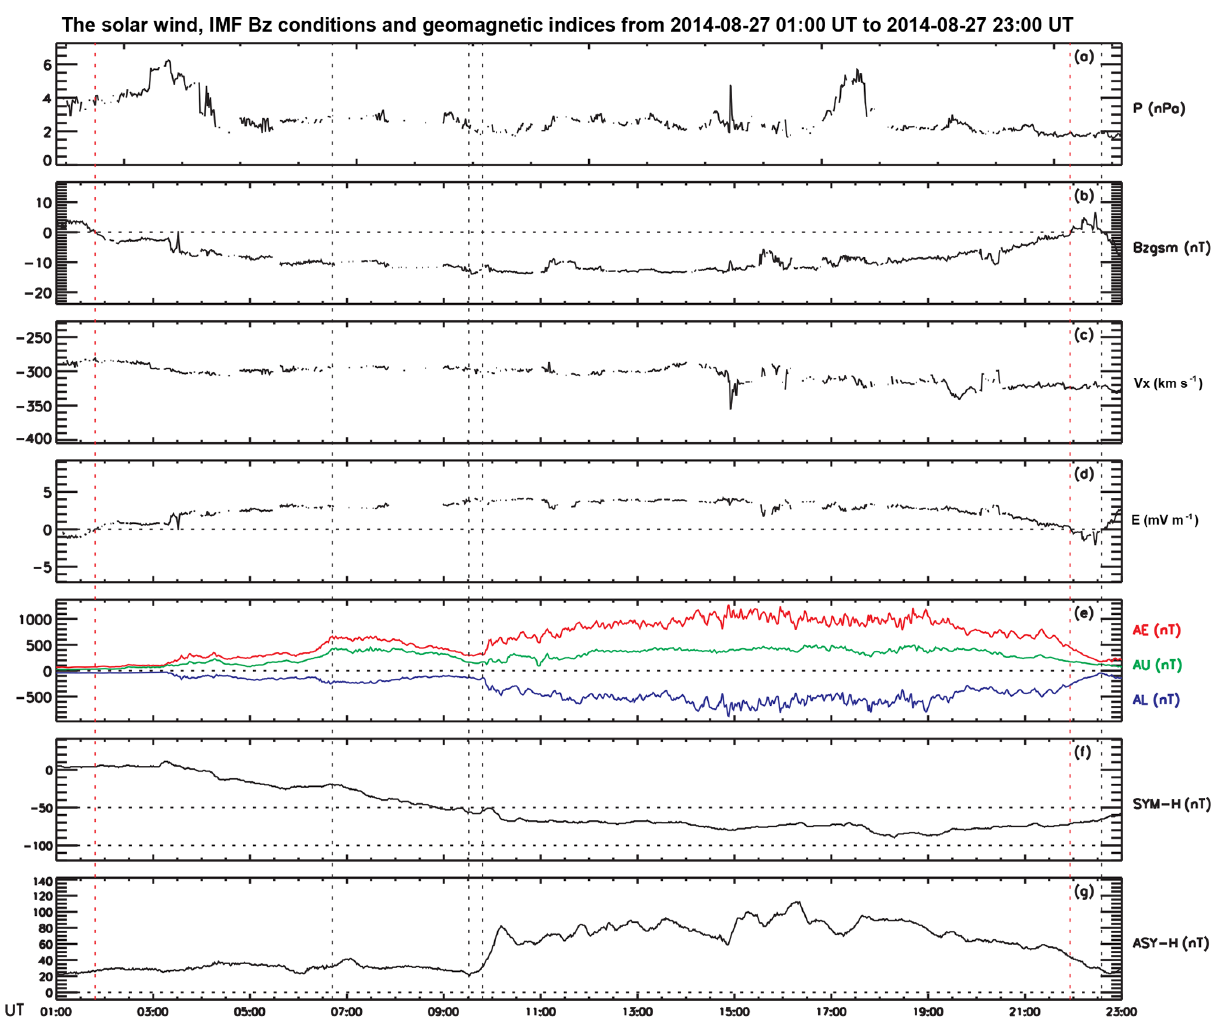
Figure 1. The solar wind, IMF B z conditions and geomagnetic indices between 01:00 and 23:00UT on 27 August 2014. From top to bottom, panels (a–g) show the change of solar wind dynamic pressure (a) , B z, IMF in geocentric solar magnetospheric (GSM) coordinates (b) , the x component of the solar wind flow speed in GSM coordinates (c) , electric field E (d) , AE–AU–AL indices (e) , SYM-H index (f) and ASY-H index (g) . From left to right, the vertical dotted lines in (a–g) panels mark the times 01:48, 06:42, 09:31, 09:48, 21:56 and 22:35UT,